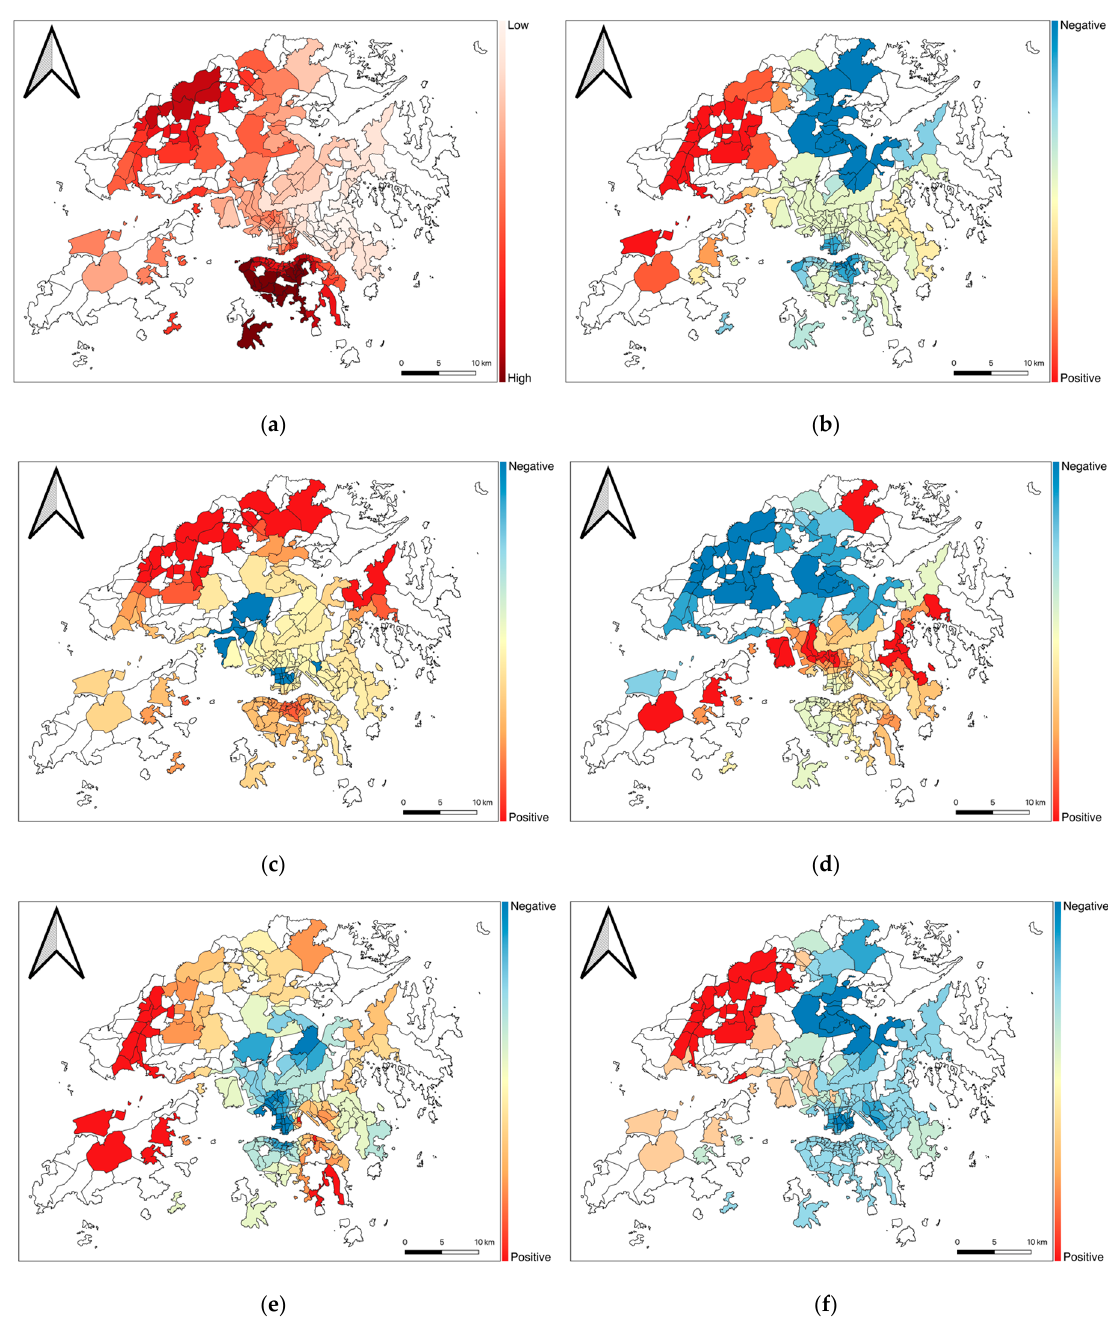
Figure 9. Spatial distribution of GWPR coefficients for R2: (a) Nodal accessibility; (b) Population density; (c) Private residential density; (d) Commercial density; (e) Green space density; (f) Sky view.